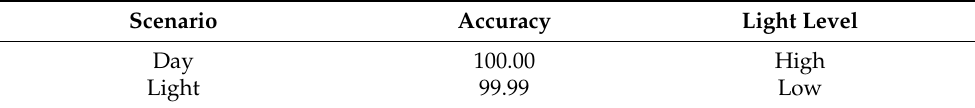
Table 7. Sensitivity analysis of the illumination of the image for the ETSIT database and the Con- vNeXtTiny backbone. Accuracy values for day and night scenarios have been computed to portray the stability of the proposed